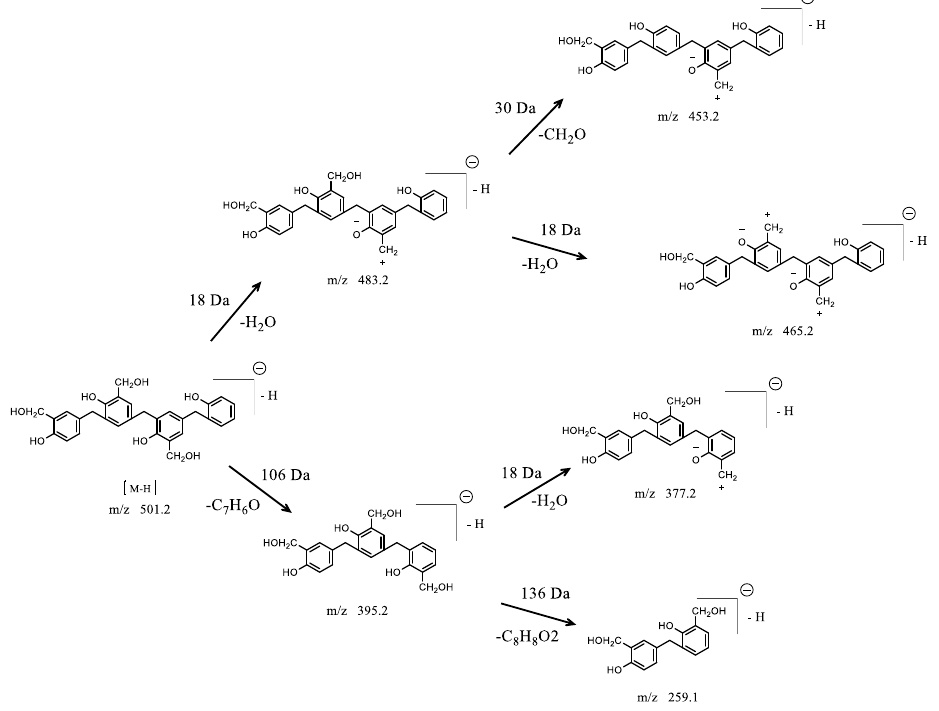
Figure 7. Proposed fragmentation pathway for the molecular ion with mass-to-charge ratio of m/z 501.2.